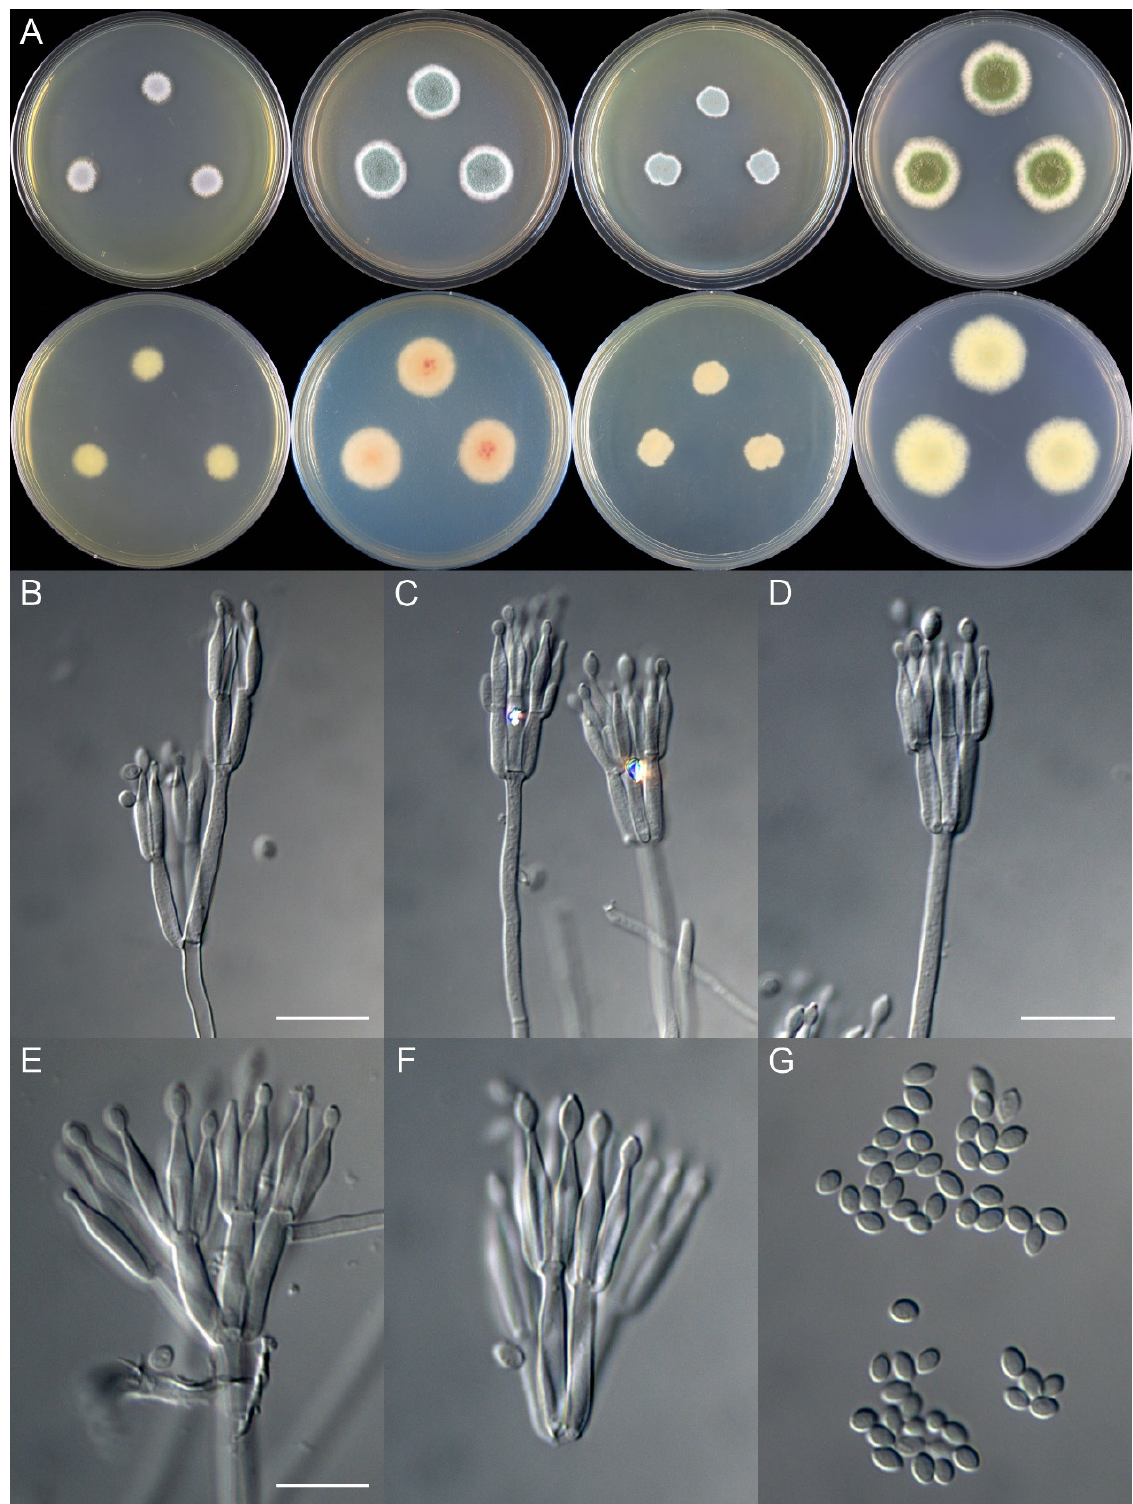
Figure 2. Colonial and microscopic morphology of Talaromyces ginkgonis (10725). ( A ) Colony phe- notypes (25 °C, 7 days; top row left to right, obverse CYA, MEA, YES, and PDA; bottom row left to right, reverse CYA, MEA, YES, and PDA); ( B – F ) Conidiophores; ( G ) Conidia. Bars: B = 15 μ m, applies to C; D = 12.5 μ m; E = 10 μ m, applies to F and G.